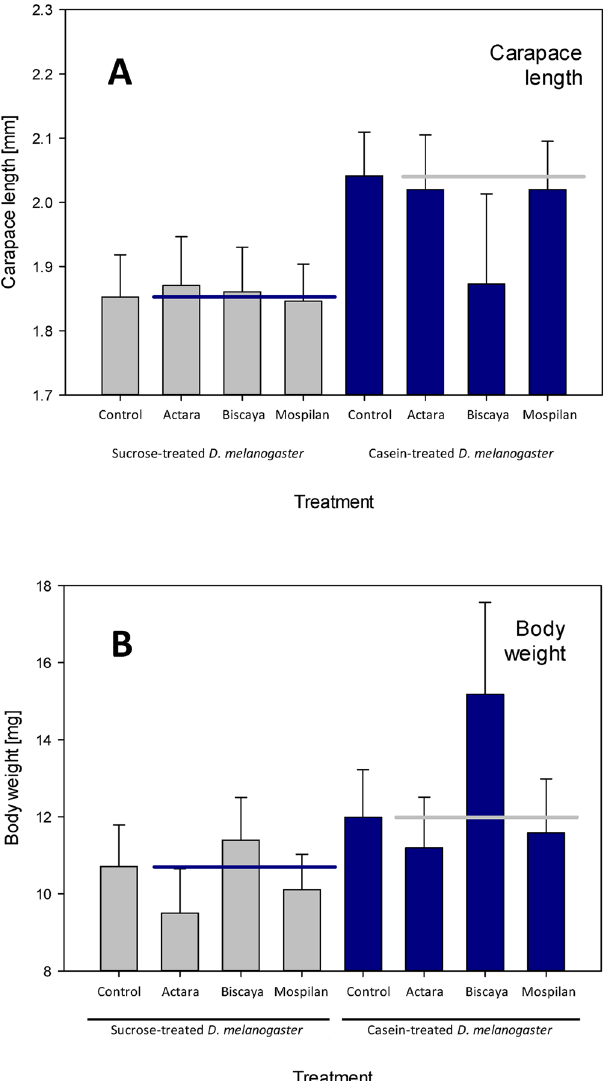
Figure 2. Effects of dietary intervention and treatment with neonicotinoid insecticides on spider growth. ( A ) Carapace length. ( B ) Body weight. Horizontal lines indicate mean control